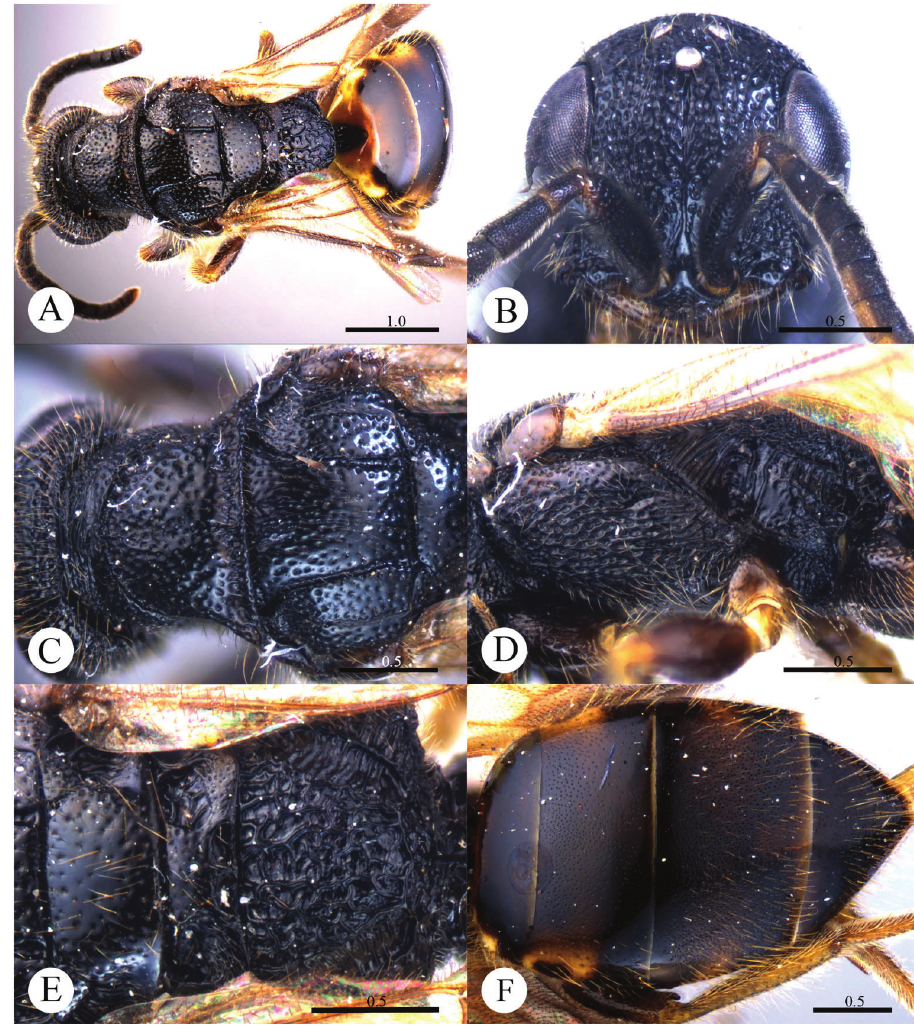
Plate 1. Cleptes albonotatus sp. n., holotype, female. A Habitus dorsal B Head anterior C Pronotum and mesoscutum dorsal D Mesopleuron and metapleuron lateral e Mesoscutellum, metanotum and propo- deum dorsal F Metasoma dorsal. Scale bars in mm. Pubescence. Head on vertex and clypeus with long (2.0–2.5 MOD), sparse and whitish hairs. Metasoma laterally on T-I and T-II with short (1 MOD), sparse and white hairs; dorsally and laterally on T-III and T-IV with long (2.2 MOD) and dense hairs. Colouration . Head and mesosoma black, without metallic reflections. Mandibles black, with anterior half testaceous. Antennae black, with ventral sides of F-IV to F-XI testaceous. Tegulae blackish-brown. Legs blackish-brown, with trochanters, tibiae and tarsi testaceous. Metasoma blackish-brown, T-I laterally and on the anterior half testa- ceous, T-II laterally with distinct pale